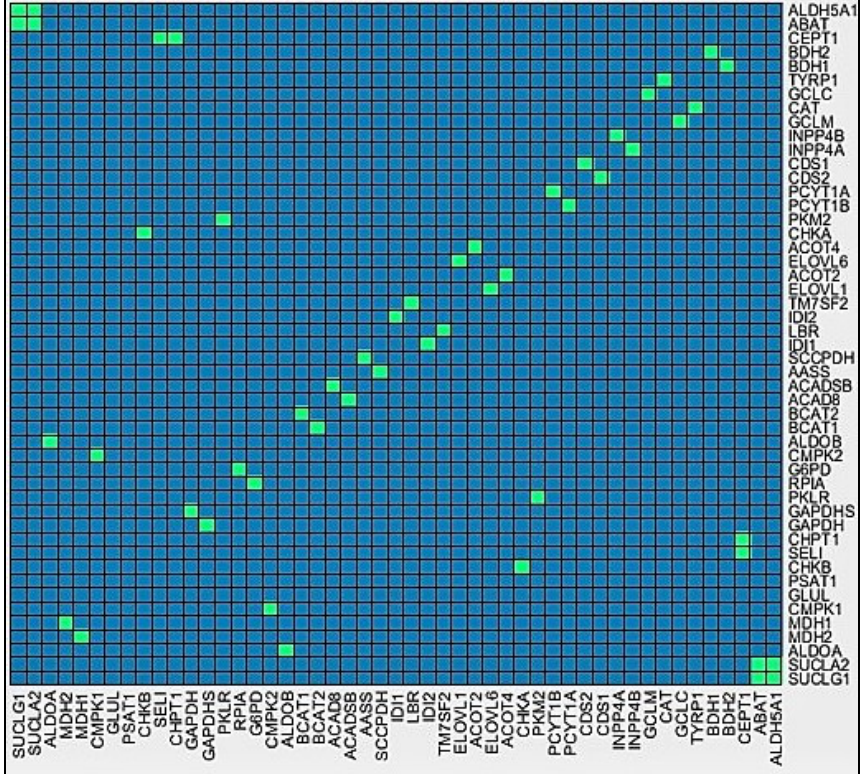
Figure 6. The relationship of the genes detected in double gene deletion analysis. The synthetic lethal gene pairs whose deletion influences growth notably are demonstrated in green.